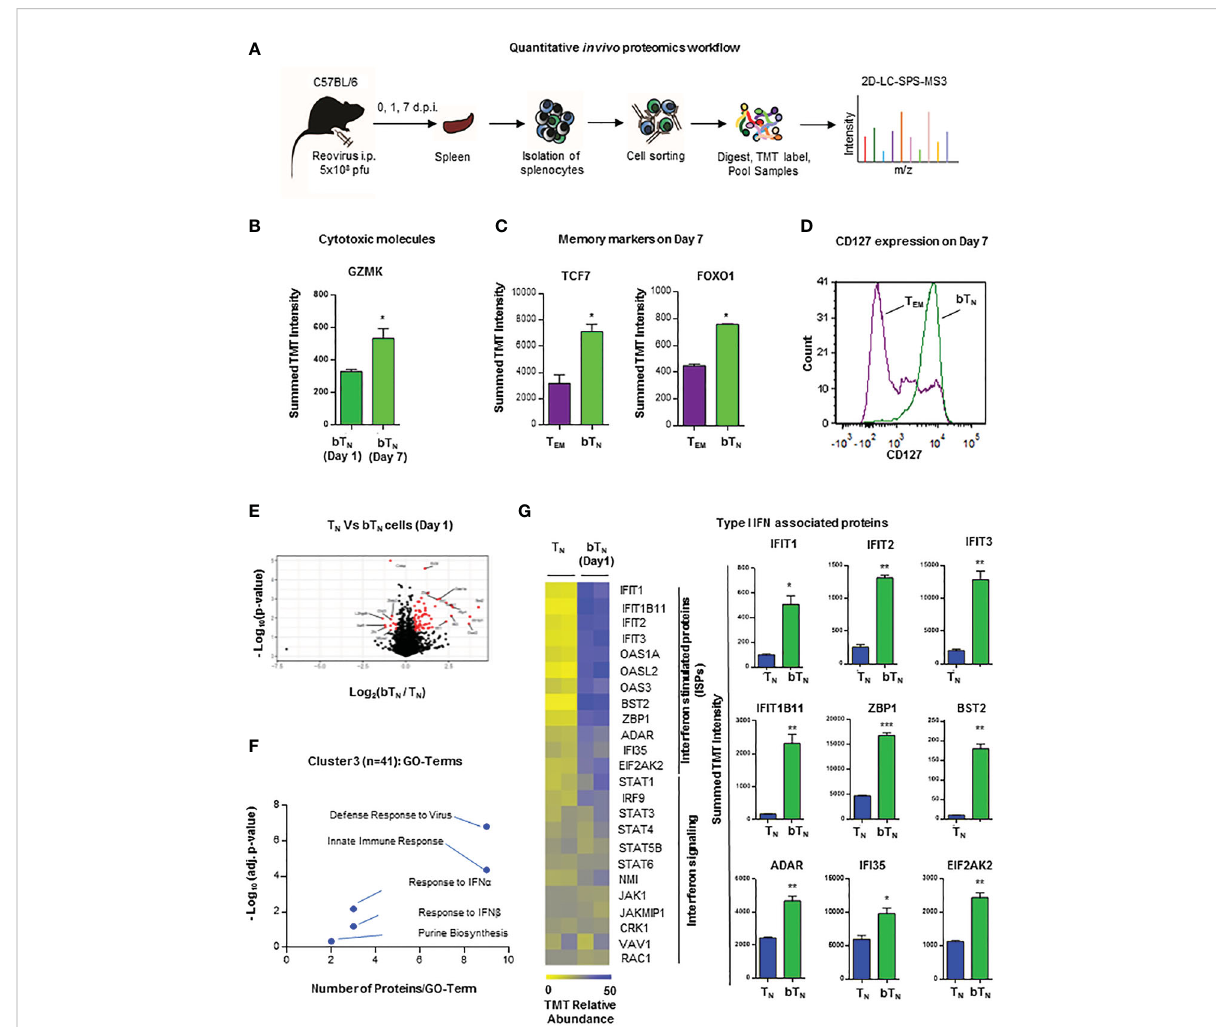
FIGURE 2 Quantitative in vivo proteomic analysis of CD8 bT N cells. (A) Schematic for the work fl ow of quantitative in vivo proteomics with T cells isolated from spleens of C57BL/6 mice (n=5 mice pooled for isolation of each cell type in an independent experiment). (B) Bar graph for protein expression from quantitative proteomics of granzyme K expression in CD8 bT N cells (1 d.p.i. and 7 d.p.i.). (C) Bar graphs for protein expression from quantitative proteomics of memory markers TCF7 and FOXO1 expression in T EM cells (7 d.p.i.) and CD8 bT N cells (7 d.p.i.). (D) Histogram overlay for memory marker CD127 in T EM cells (7 d.p.i.) and CD8 bT N cells (7 d.p.i.). Representative histogram shown from spleen of one mouse (n=3 mice) (E) Volcano plot compares all identi fi ed proteins across CD8 T N and CD8 bT N cells (1 d.p.i.). (F) Cluster 3 of GO TERM analysis of proteomics depicting differentially regulated pathways in CD8 bT N cells compared to T N cells. (G) Heatmap for the relative levels of interferon- stimulated proteins and interferon signalling proteins identi fi ed in T N and CD8 bT N cells (1 d.p.i.). Corresponding bar graphs show the levels of several type I interferon-associated proteins in T N and CD8 bT N cells. Two-tailed Student ’ s t -test with 95% con fi dence interval was used for statistical analysis. Not signi fi cant (ns) = p > 0.05; * p < 0.05; ** p < 0.01; *** p <